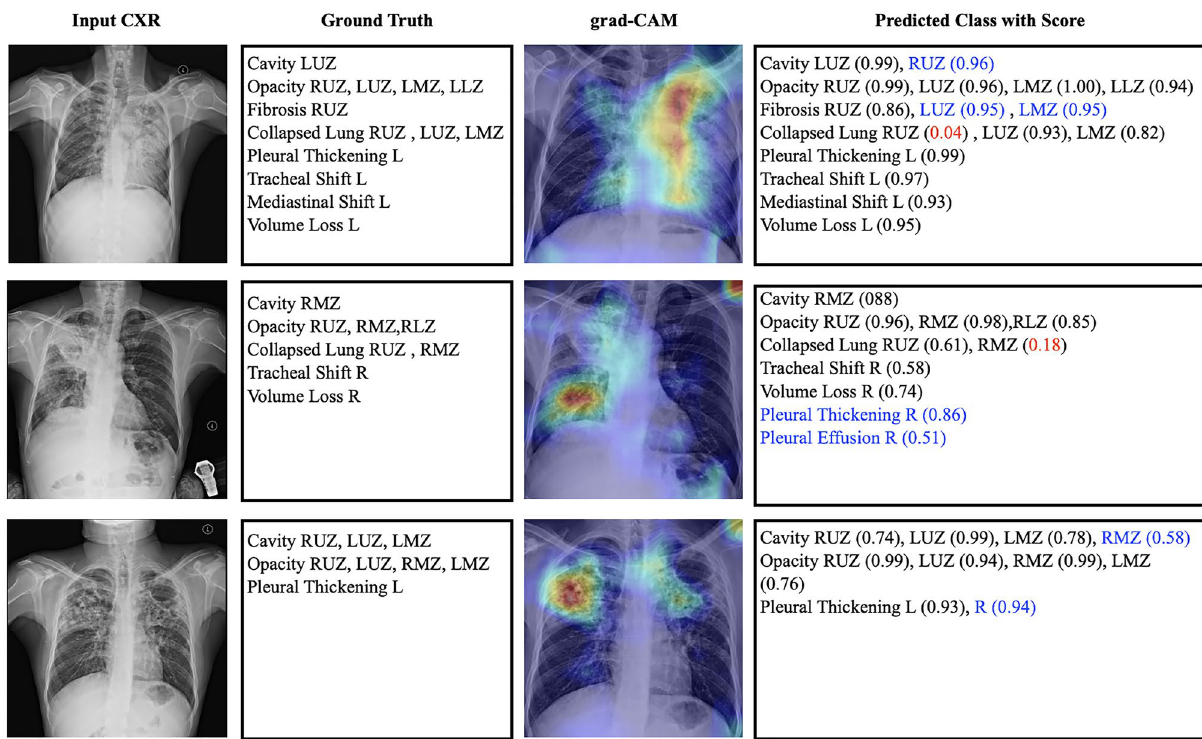
Figure 4. Grad-CAM image overlaid with chest Xray of Tuberculosis patients. Panel (Input CXR) shows the chest radiographic images of patients. Panel (ground truth) shows the radiologist findings of abnormalities in CXR. Panel (grad-CAM) shows the gradient-weighted class activation map overlaid with input CXR image. Panel (predicted class with score) shows the abnormality prediction with class score 0 to 1. Red coloured class prediction is false negative. Blue coloured prediction is additional findings (either true positive or false positive). RUZ right upper zone, RMZ right mid zone, RLZ right lower zone, LUZ left upper zone, LMZ left mid zone, LLZ left lower zone, R right lung, L left upper zone, Tracheal shift towards to left is also visible in CXR. CXR also shows signs of severe build-up asym- metry of intrathoracic pressures and mediastinum (the heart, trachea, great vessels and esophagus to shift towards left). The network predicted class with scores shows that all manifestations are correctly predicted and are aligned with radiologist (HG) findings, except collapsed lung in right upper zone (score 0.04 with maximum 1). In addition, thenetwork also predicted Cavity lesion in right upper zone, Fibrotic scars in upper and mid zones of left lung. The grad-CAM heat maps are in line with ground truth focused on left lung and right medi- astinal borders. Heatmap also shows the signs in right lower zone and in cardiomediastinal contour areas which is over estimated. The second row of Fig. 4 represents X ray of 37-year-old male X-ray withGround truth showing lung abnor- malities in right hemithorax. Chest X-ray showed the ill-defined patchy opacity in right lung with Cavitation in right mid zone. Right upper and mid zone exhibited lung collapse and shows signs of volume loss in right lung. Tracheal deviation towards the right side also visible due to the abnormal pressure on chest. The algorithm predictions are in line with ground truth except the false negative on Collapsed lung on right mid zone (score 0.18). Network also predicted Pleural thickening on right with score of 0.86 and Pleural Effusion on right lung (score 0.51) are verified and confirmed with radiologist (HG). The grad-CAM heatmap analysis also points to the ground truth abnormalities on left diaphragm and the left mediastinal border of left hemithorax. The coarse localisation of the predicted abnormalities can be visualized in heatmap. The Opacity on right lower Zone was highlighted and overall the heatmap wasin accordance with ground truth and verified by radiologist. The sample in third row in Fig. 4 shows 30-year-old female patient confirmed with active pulmonary tuber- culosis. The ground truth shows that the pathological changes in X-ray are bilateral upper zone and left mid zone Cavitation, Opacity in bilateral upper and mid zones and Pleural Thickening on left lung. Network predicted all classes to be consistent with ground truth and in addition Cavity lesion on right mid zone (score 0.58) and right lung Pleural Thickening (score 0.94) which is verified and agreed by radiologist. Heatmap produced by the algorithm was analysed by radiologist and showed alignment with ground truth. Some over estimation on right lower zone in grad-CAM heatmap was noticed.